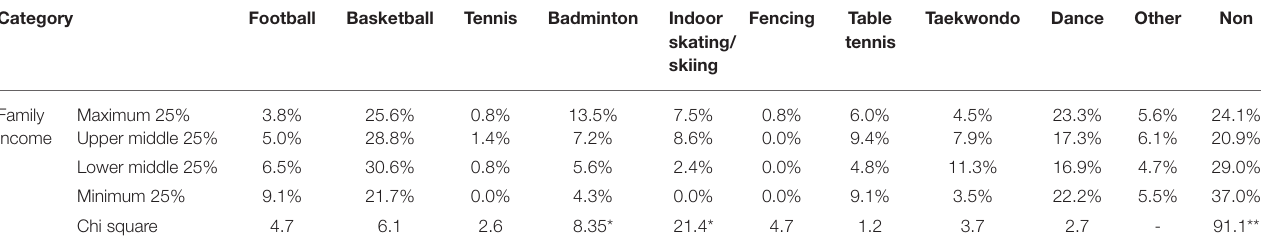
TABLE 5 | Distribution of off-campus sports class selection after “DR” under different family income. Category Table